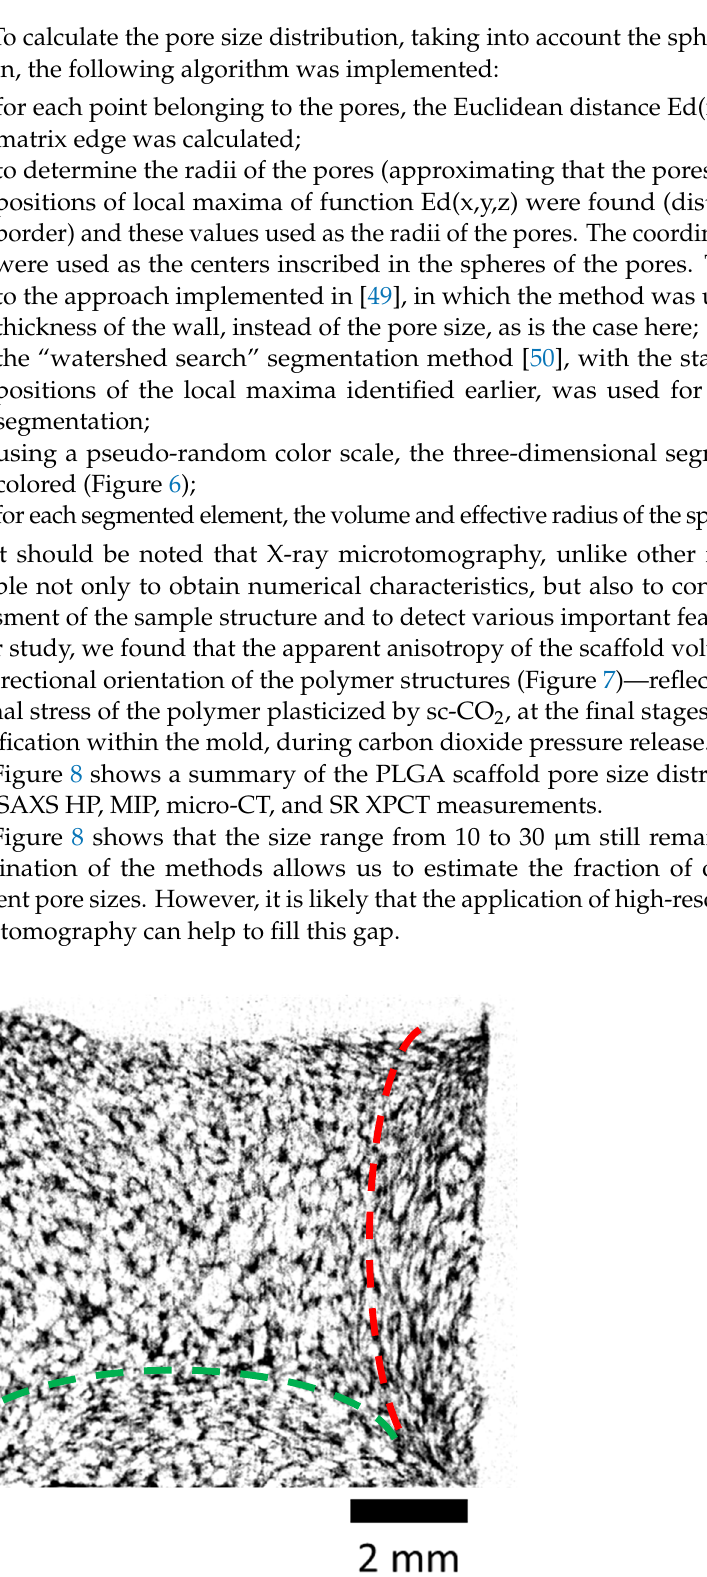
Figure 7. X-ray microtomography (micro-CT) images of PLGA scaffold cross-sections, demonstrating the presence of selected directions (anisotropy) in their structure (red and green dotted lines show the regions of high anisotropy).